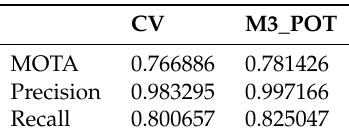
Table 4. Results of the comparison of Computer Vision (CV) and Mask R-CNN base algorithm for plant detection on